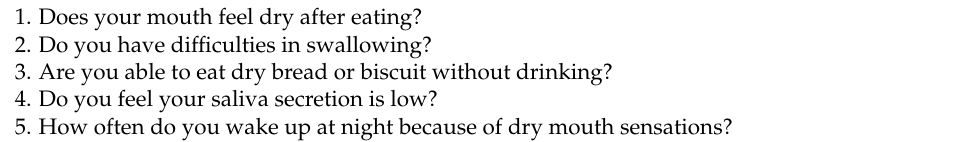
Table 1. Xerostomia sensations questionnaire.